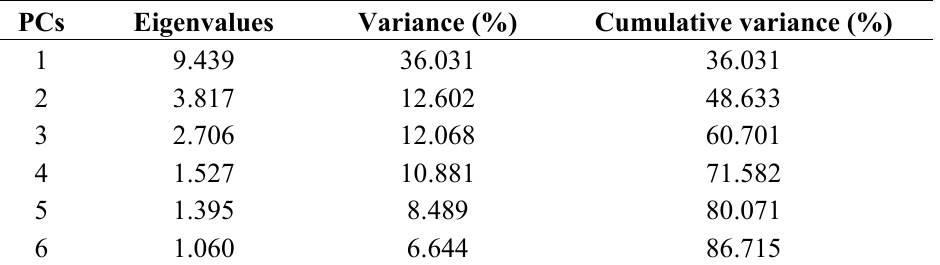
Table 5. Principal components (PCs) for basin characteristic and climate factors.